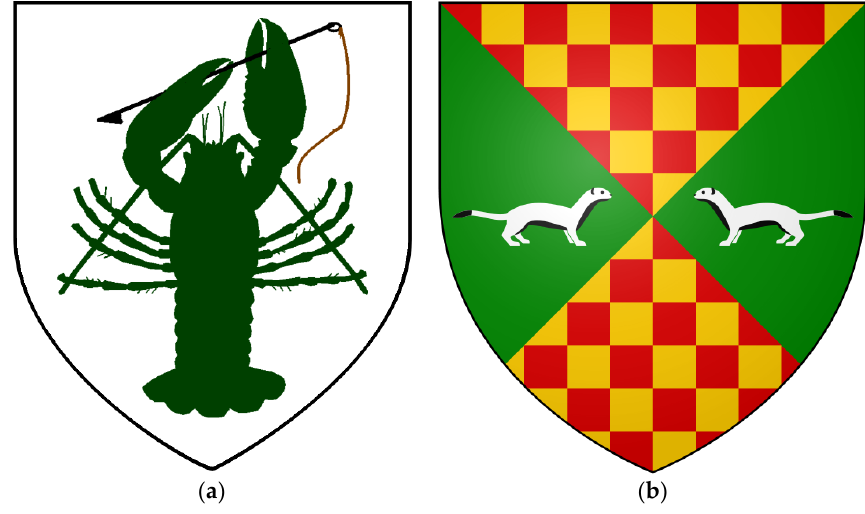
Figure 6. Curious charges of lesser houses: ( a ) House Magnar shows a green lobster holding a harpoon; ( b ) House Ferren has two white ferrets (A Wiki of Ice and Fire: House Ferren.svg 2018).